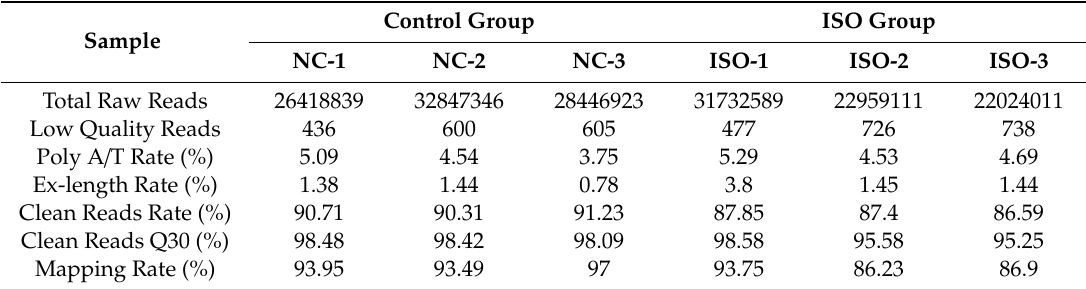
Table 1. Summary of reads from raw data and clean reads for microRNAs (miRNAs) sequencing in rat hearts.